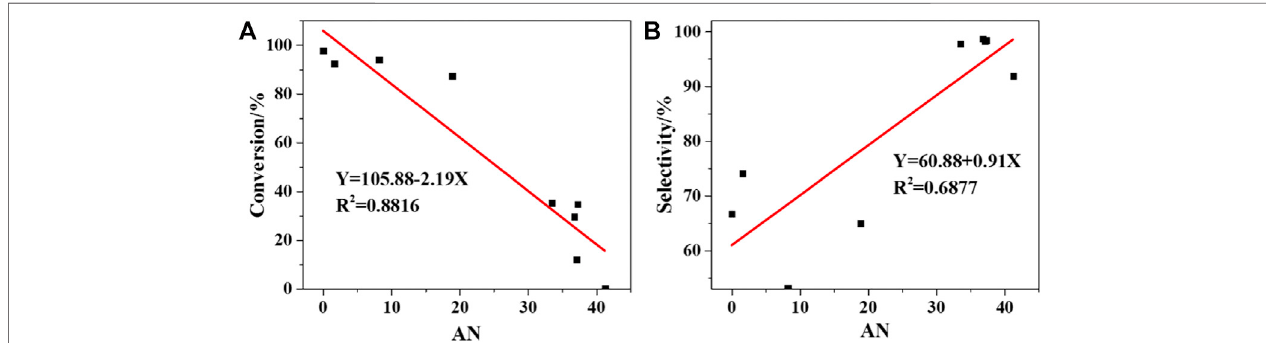
FIGURE 7 | Correlation between AN and reactivity: (A) Conversion of 2nd hour, (B) Selectivity.